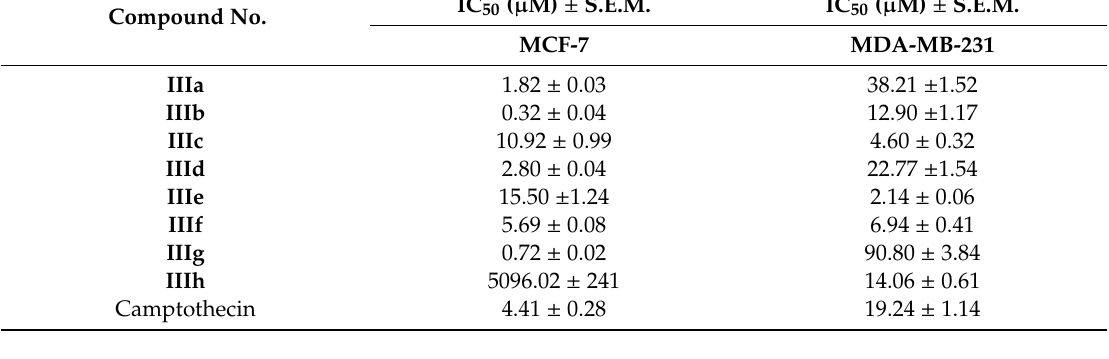
Table 2. Cytotoxicity of the synthesized N-substituted coumarin-4-acetamides IIIa–h and camptothecin. Compound No.